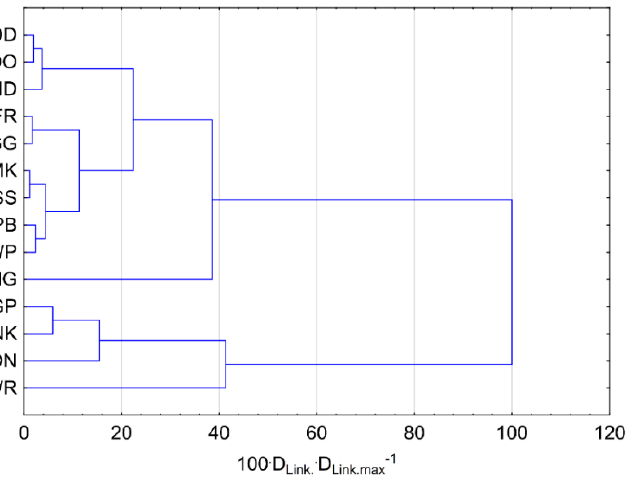
Figure 9. Results of CA based on the results of multitemporal trend analysis of 7 day minimum flows (DL7) over the period 1951–2020.